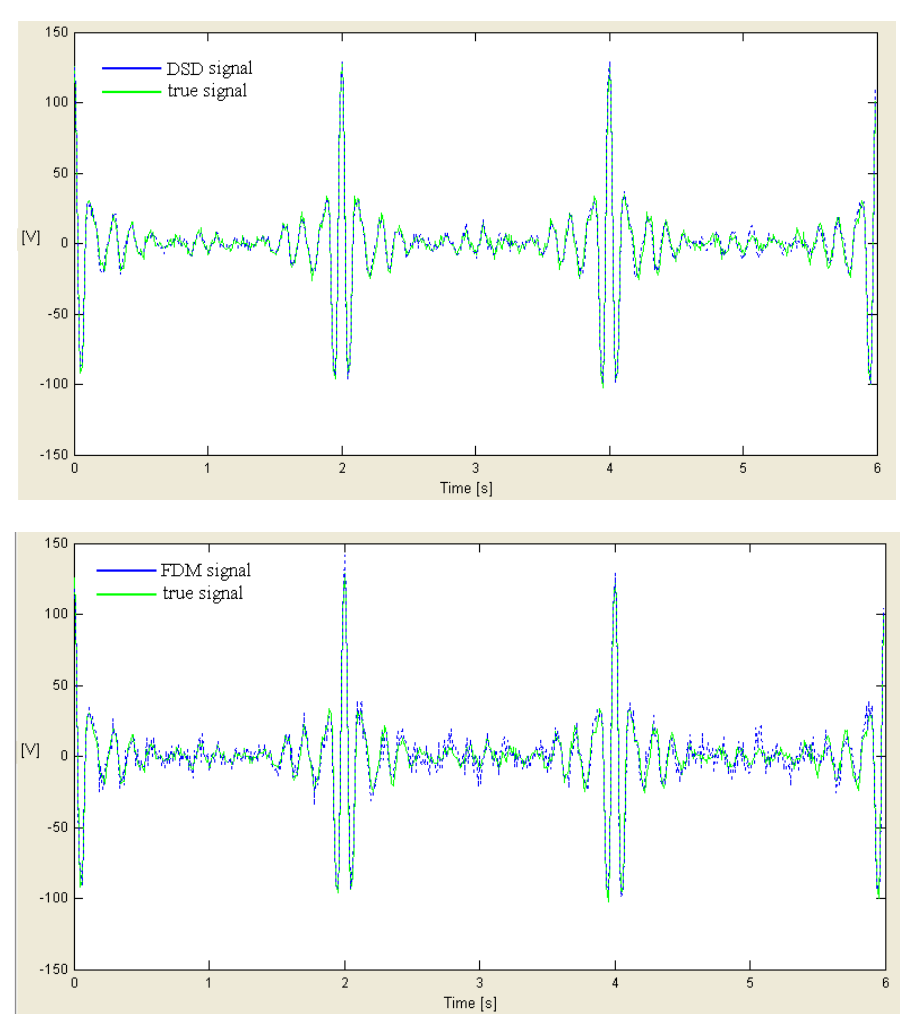
Figure 6. Comparison between processing effects of DSD and FDM of the same signal delivered by a pressure sensors since DSD partly includes FDM features.